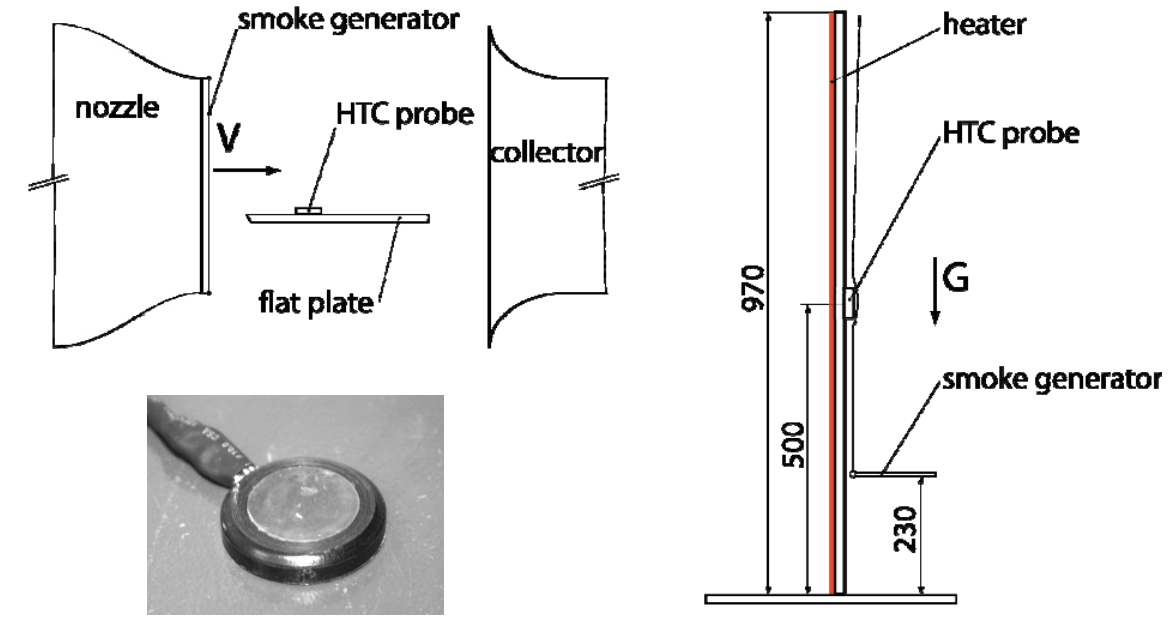
Figure 1: Experimental setup – horizontal forced flow and HTC probe (left) and natural convection on vertical plate